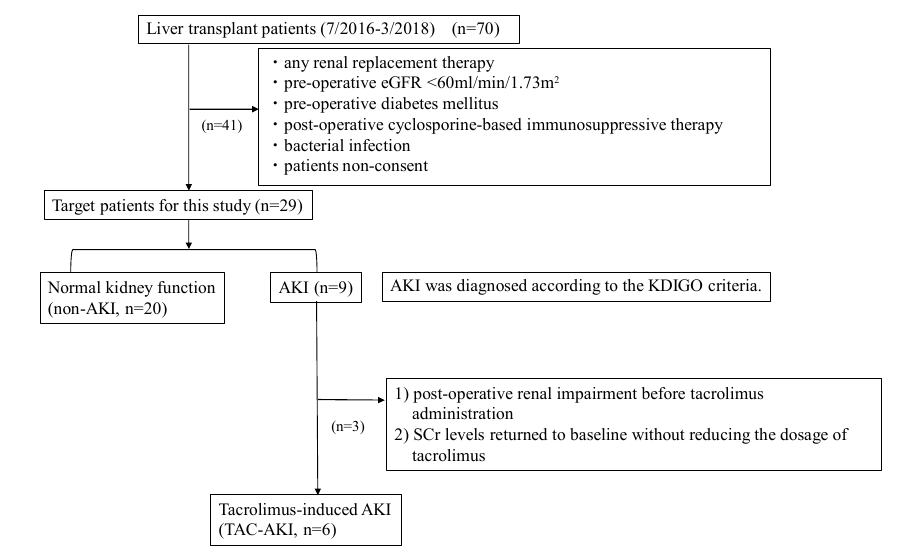
Figure 4. Diagnostic algorithm of patient selection. A total of 70 patients (29 men and 41 women; age, > 18 years) who underwent living donor liver transplantation at Kyushu University Hospital between July 2016 and March 2018 were enrolled in the study after obtaining written informed consent. Patients with renal impairment due to septic ischemia, antibiotics, hepatorenal syndrome, or other causes and patients who had received renal replacement therapy were excluded. Additionally excluded were patients with renal impairment despite low tacrolimus levels, patients whose SCr levels were una ff ected by changes in the tacrolimus dosage, patients with perioperative renal impairment before postoperative tacrolimus-based immunosuppression treatment, and patients with a preoperative eGFR ( < 60 mL / min / 1.73 m 2 ) or diabetes mellitus. Ultimately, 20 patients without AKI (control) and 6 patients with tacrolimus-induced AKI were included in the analysis. AKI, acute kidney injury; eGFR, estimated glomerular filtration rate; KDIGO, Kidney Disease Improving Global Outcomes; SCr, serum creatinine.